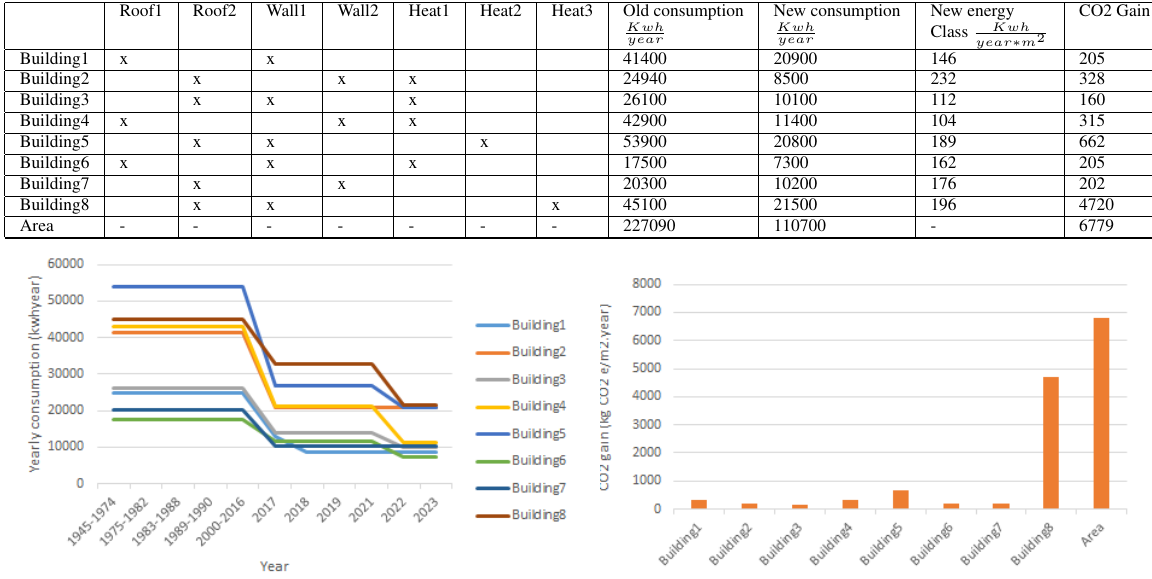
Figure 8. Influence of energy renovation packages on yearly energy consumption and CO2 emissions on an